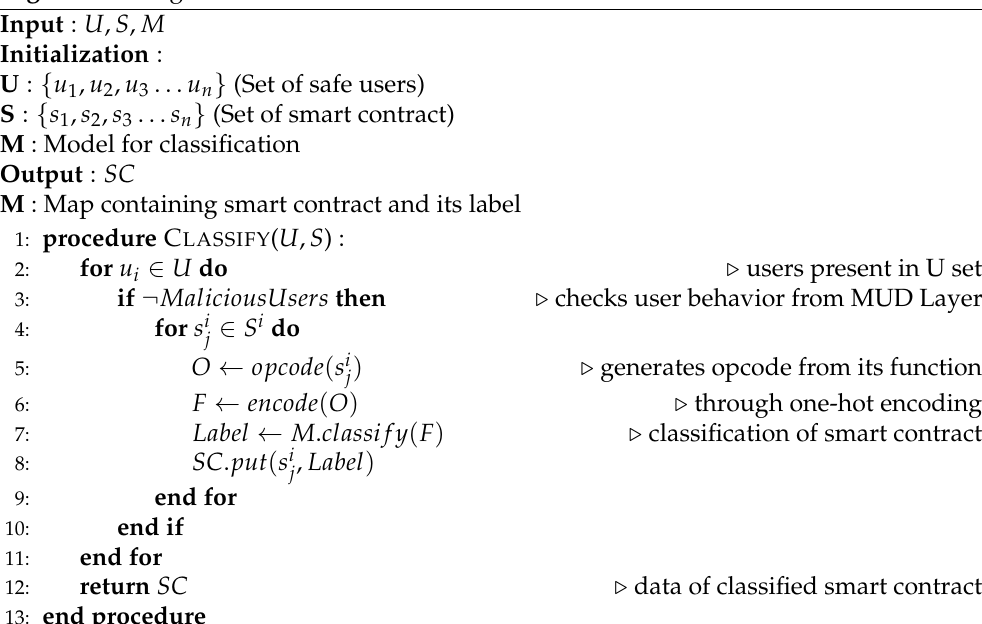
Algorithm 2 Algorithm for malicious smart contract